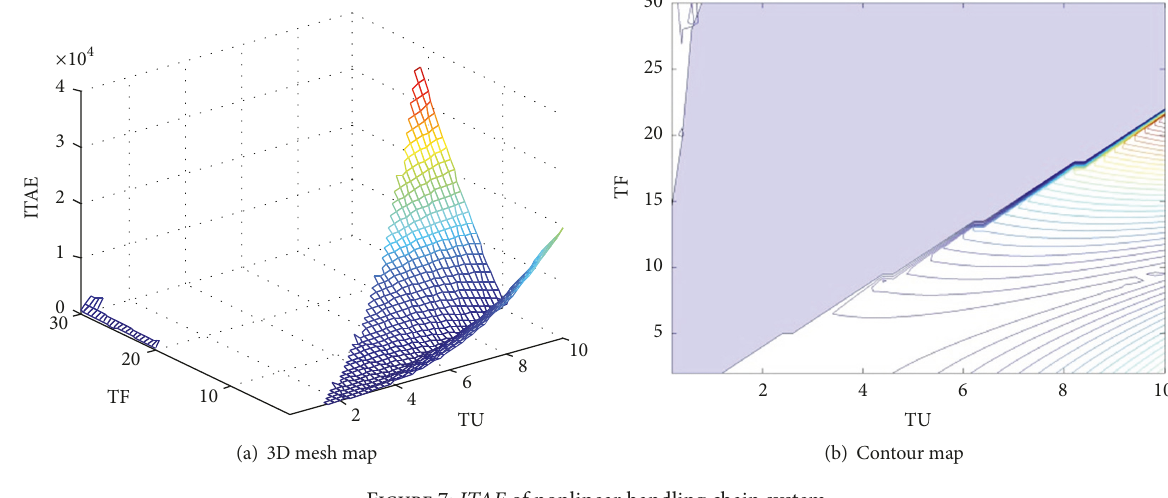
Figure 7: ITAE of nonlinear handling chain system.